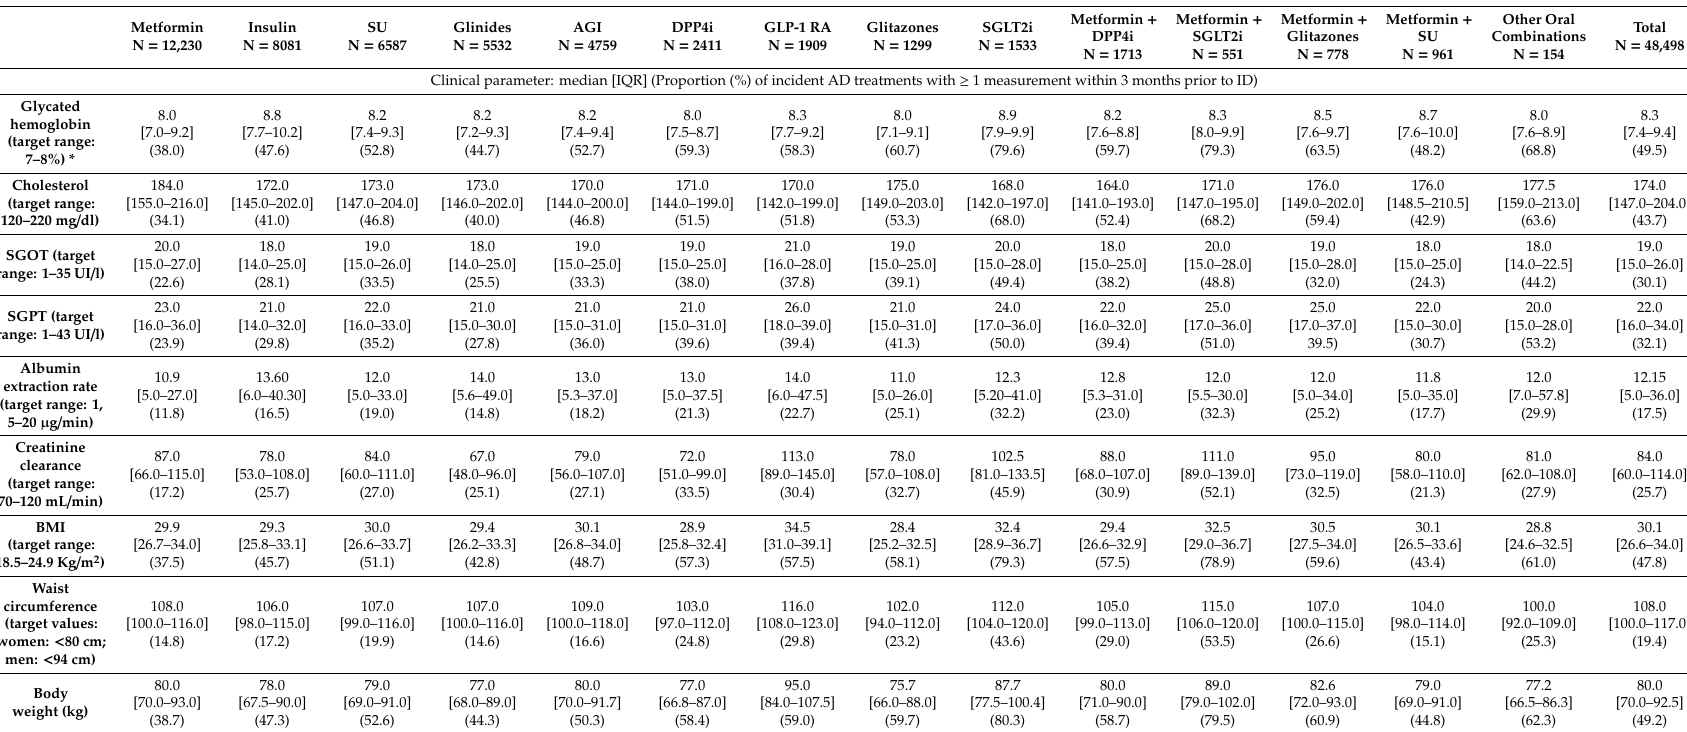
Table 2. Baseline clinical parameters of incident AD treatments in Palermo LHU during the years